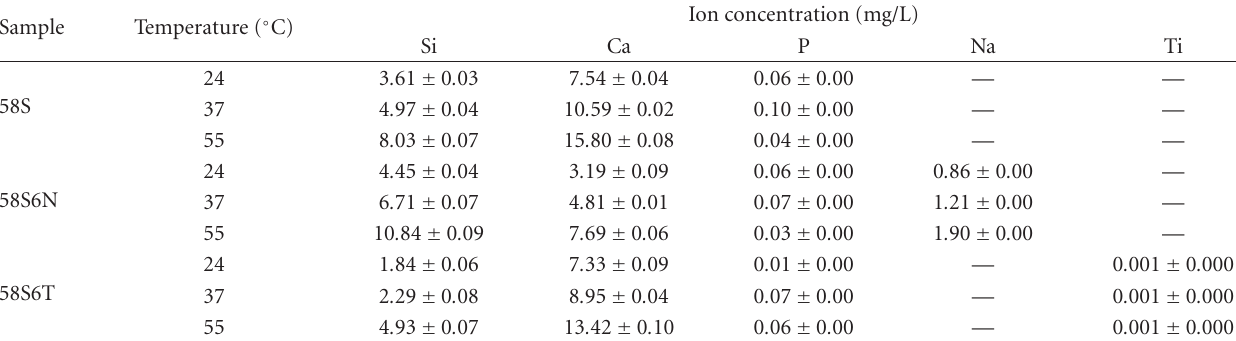
Table 2: Ionic concentrations of bioactive glasses after soaking in Tris-HCl bu ff er solution for 6 hours at 24 ◦ C, 37 ◦ C, and 55 ◦ C, respectively. Sample